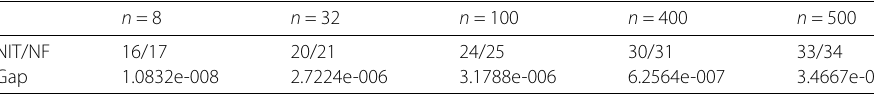
Table 3 Numerical results of Example 3